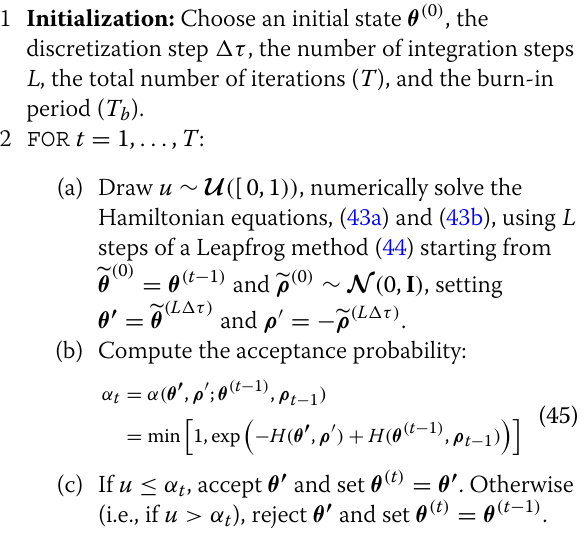
Algorithm 16 Hamiltonian Monte Carlo (HMC) Algo-